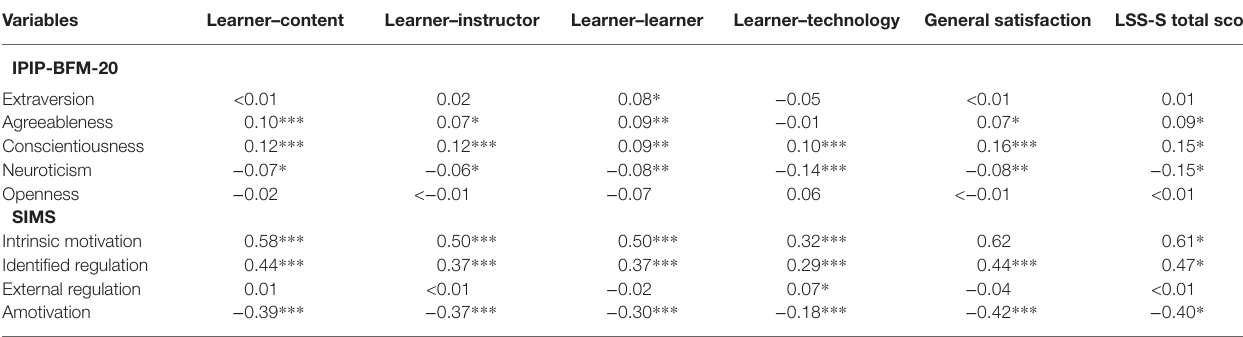
TABLE 5 | Pearson correlation coefficients between scores on the LSS-S and scores on the IPIP-BFM-20 and the SIMS. Variables